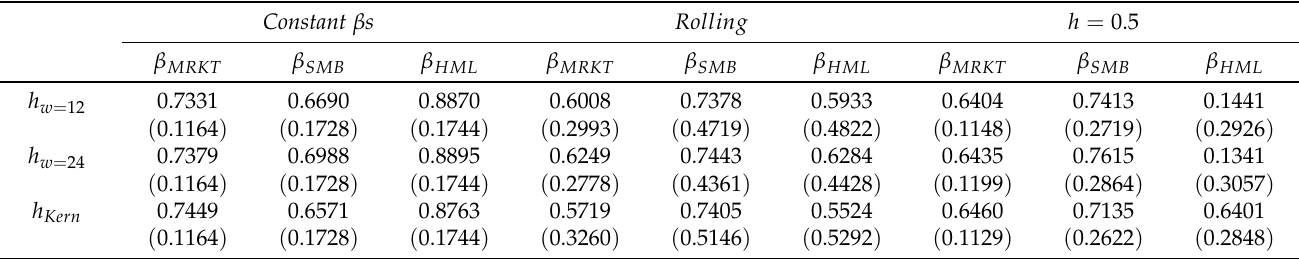
Figure 1. Time-varying optimal bandwidth parameters. The figure reports the plots of the optimal bandwidth parameters considering different datasets and methods for computing the RMSE t , as discussed in Section 3.1. The bandwidths reported in red are computed according Equation (5) using the classical rolling window approach with w = 12, while, for those in blue, w = 24. On the other hand, the bandwidths in black are computed using the kernel average method discussed in Equation (6). Table 2. Factor risk loading estimates for Ford